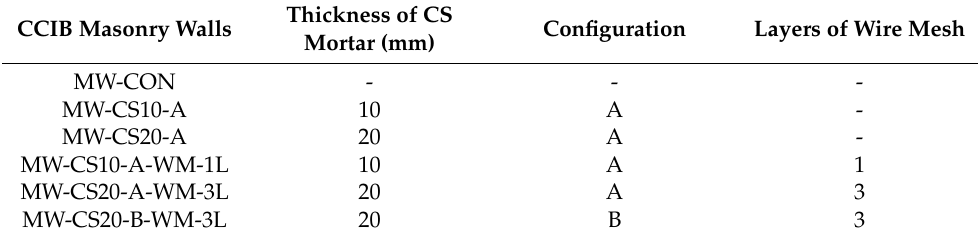
Figure 1. Typical details of strengthening configurations: ( a ) Configuration A; ( b ) configuration B. Table 1. Details of CS mortar strengthening.